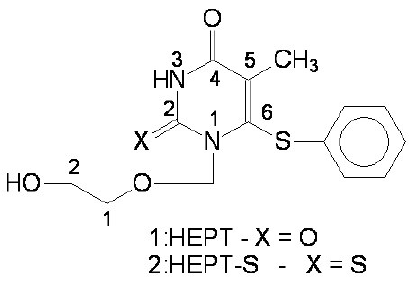
Figure 1. The structure of HEPT: 1-[(2-hydroxiethoxi)-methyl]-6-(phenylthio) thymine. The 1-[(2-hydroxiethoxi)-methyl]-6-(phenylthio) thymine congeners (HEPT ligands) [8] –